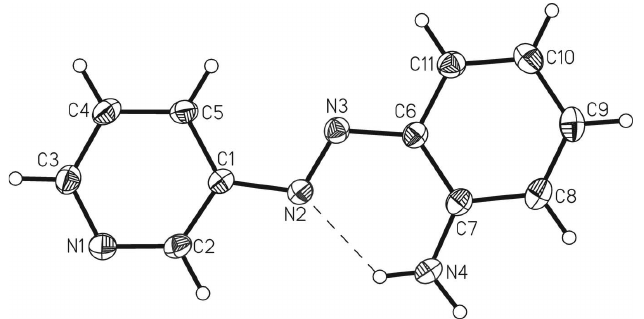
Figure 1 Molecular structure of the title compound with labeling and displacement elliposids drawn at the 50% probability level. The intramolecular N— H (cid:2)(cid:2)(cid:2) N hydrogen bond is shown with dashed